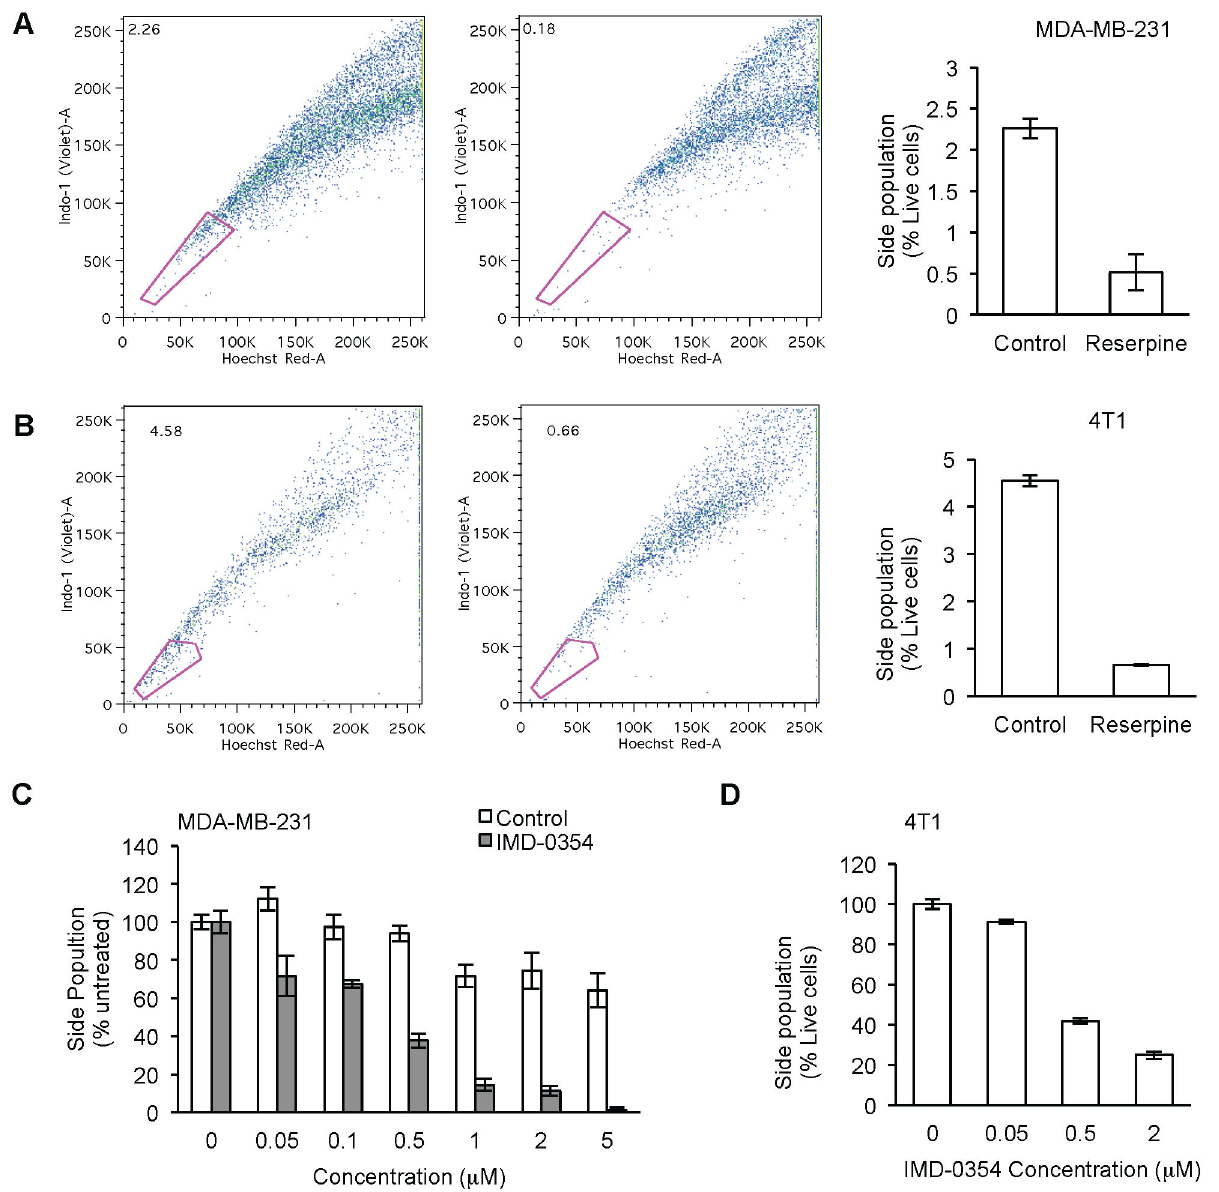
Figure 3. IMD-0354 inhibits side population of CSCs in human and murine breast cancer cells. Side population of CSCs as analyzed by FACS and their Hoechst 33342 dye efflux inhibition by reserpine in MDA-MB-231 (A) and 4T1 (B). Dose curve of IMD-0354 on side population in MDA-MB-231 (C) and 4T1 (D). Data are shown as mean ± SEM. doi: 10.1371/journal.pone.0073607.g003 FITC positive cells at 300 nM and 1 µM (19 and 37 % apoptosis increase, respectively, compared to control; P-value = 0.0019 and < 0.0001, respectively), in agreement with the apoptotic cell phenotype observed under the microscope during MTT assays. Therefore, IMD-0354 has a cytotoxitc effect on both human and murine breast cancer cell lines, partially due to induction of apoptosis.